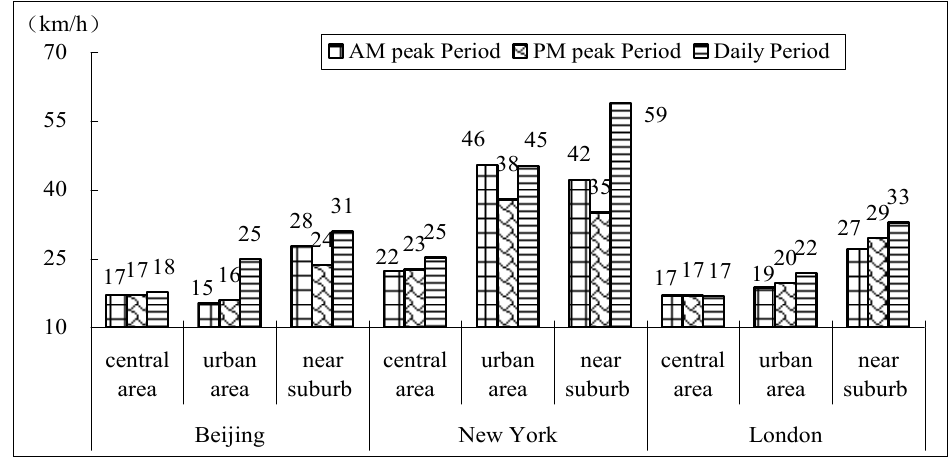
Fig. 4. Vehicle speed comparison in different grade road of Beijing, New York and